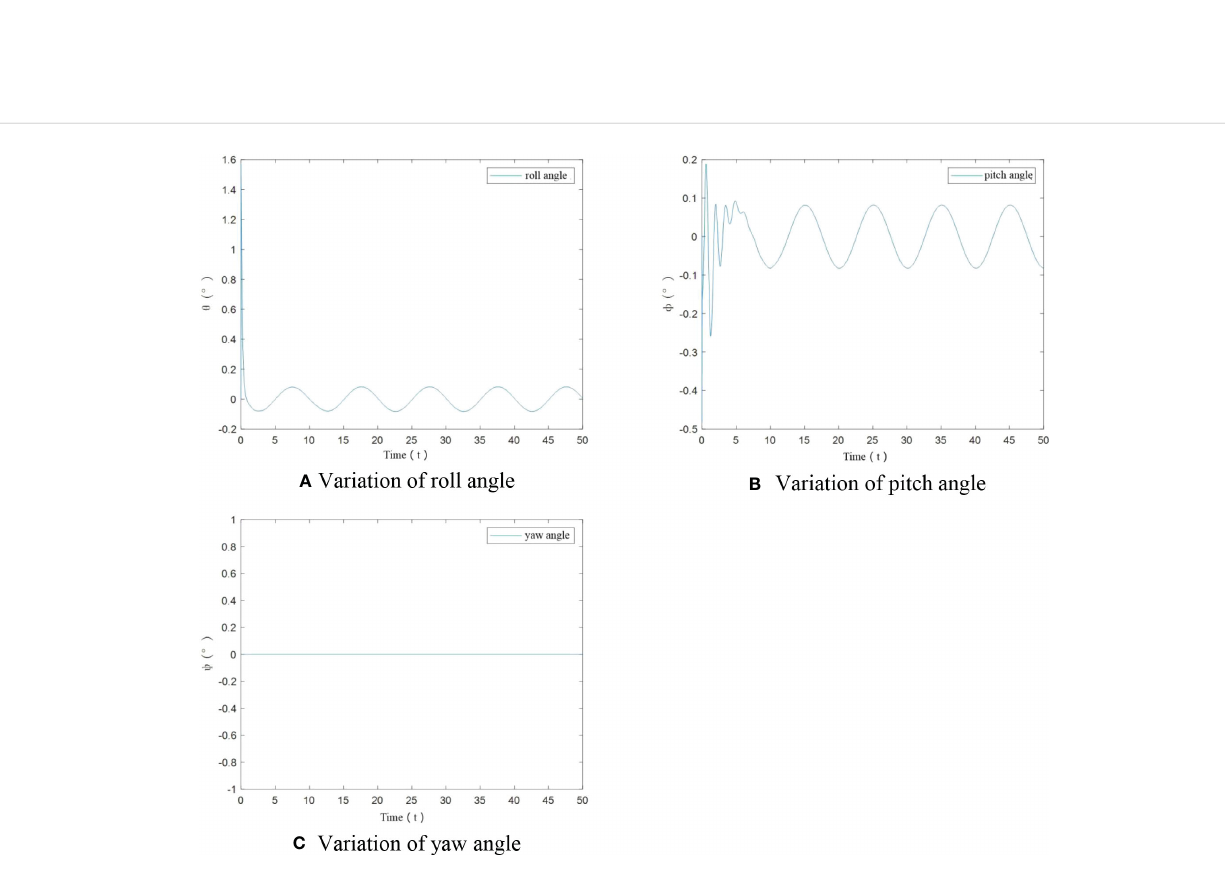
FIGURE 9 Angle variation of agricultural UAV under small load. (A) Variation of roll angle, (B) Variation of pitch angle, (C) Variation of yaw